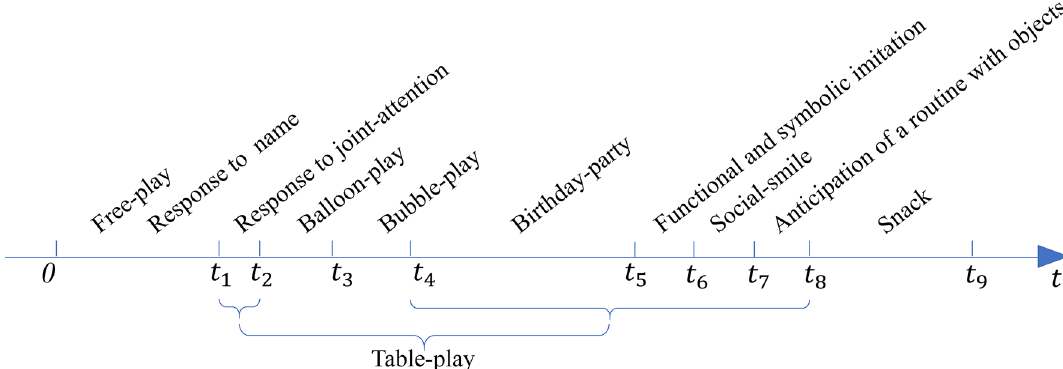
Figure 2. 10 activities segmented in the time domain for each video.